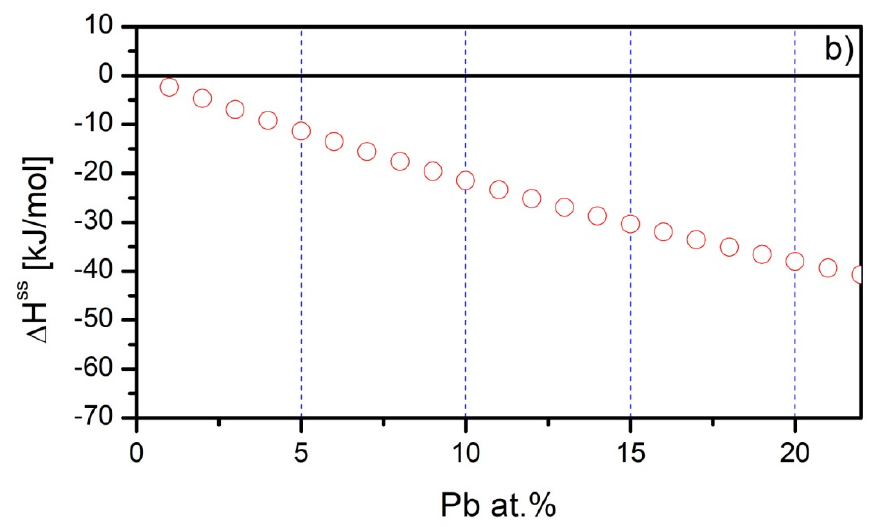
Figure 1. The formation enthalpy of solid solution Gd-Pb binary alloy ( a ) and selected range used in the present paper ( b ).